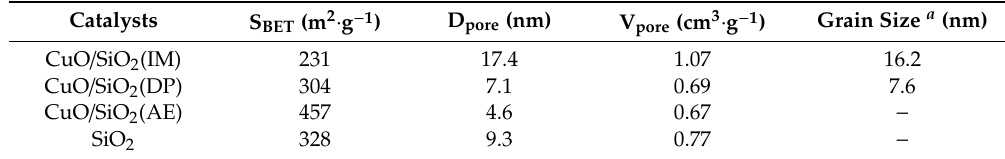
a Calculated according to the formula D = Kλ/β cos θ .